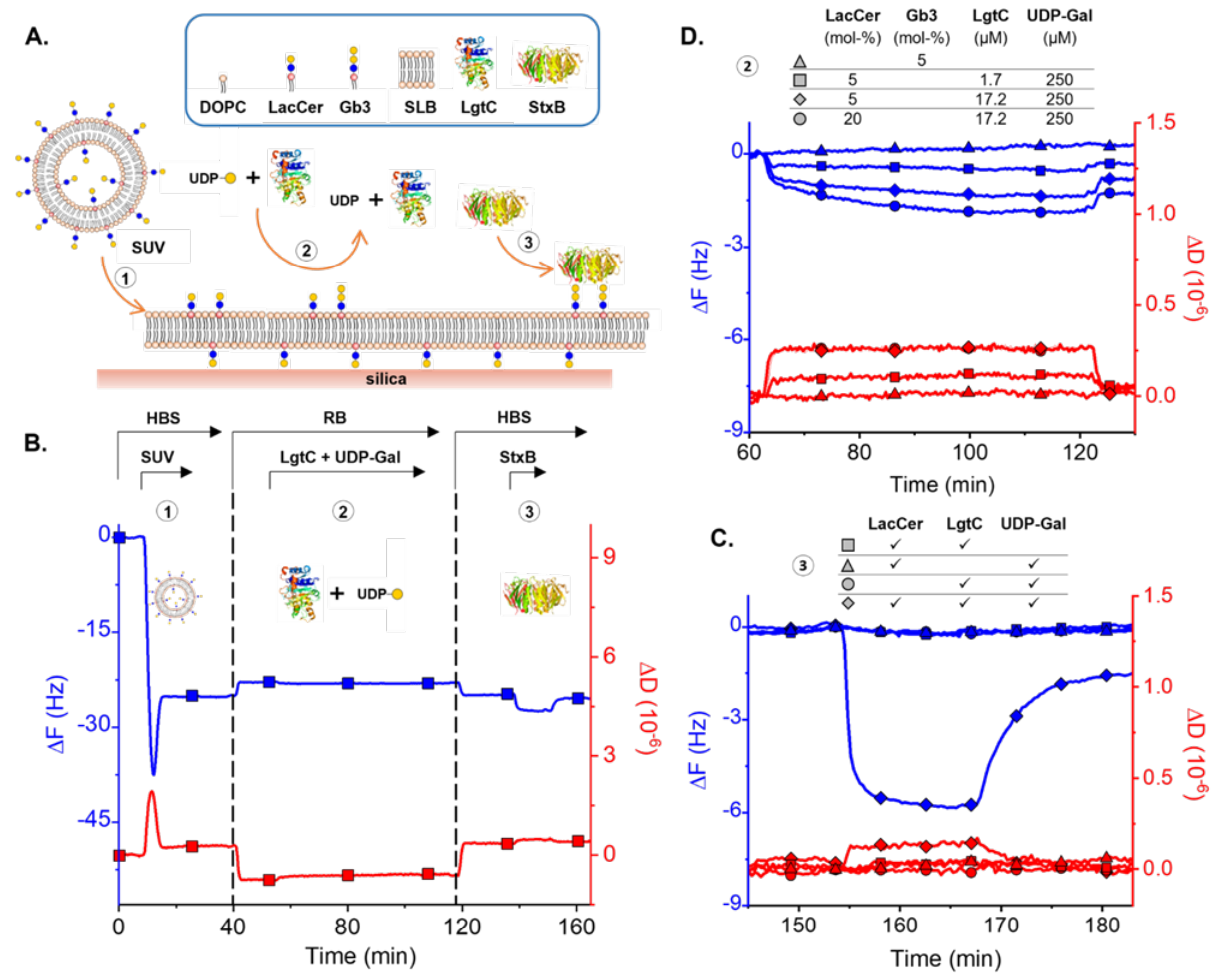
Figure 4. LgtC converts LacCer to Gb3 on supported lipid bilayers. ( A ) Schematic of the main steps of the assay: (1) supported lipid bilayer formation, (2) enzymatic conversion of LacCer into Gb3, (3) StxB binding reports on Gb3 content in the SLB. ( B ) Representative QCM-D data of the assay. A decrease in the frequency shift ( ∆ F , blue line) indicates mass binding to the surface (including hydrodynamically coupled solvent). The dissipation shift ( ∆ D , red line) provides a measure for the softness of the surface-confined film. Conditions: HBS, HEPES buffered saline (10 mM HEPES, 150 mM NaCl, pH 7.4); RB, reference buffer (20 mM HEPES, 0.5 mM MnCl 2 , 4.4 mM Tris, 1.1 mM TCEP, pH 7.4); SUV (50 µ g/mL; 5 mol-% LacCer); LgtC (60 ng/ µ L, 1.7 µ M); UDP-Gal (250 µ M); StxB (6.5 µ M); flow rate (20 µ L/min). The arrows above the graph indicate the start and the duration of sample incubation and buffer exchange steps. ( C ) Zoom onto the StxB binding step of the experiment, the same as shown in B but at higher LgtC (600 ng/ µ L, 17.2 µ M), including additional control experiments with either LacCer, LgtC or UDP-Gal missing, but otherwise identical (symbols as indicated above the graph). StxB was incubated from 155 to 167 min. ( D ) Direct monitoring of the enzyme reaction by QCM-D. LgtC on LacCer-containing SLBs at different reaction conditions. Conditions tested (symbols as indicated above the graph): 5 and 20 mol-% LacCer, 1.72 µ M (60 ng/ µ L) and 17.2 µ M (600 ng/ µ L) LgtC, reaction time 1 h. Control: 5 mol-% Gb3, run with buffer for 1